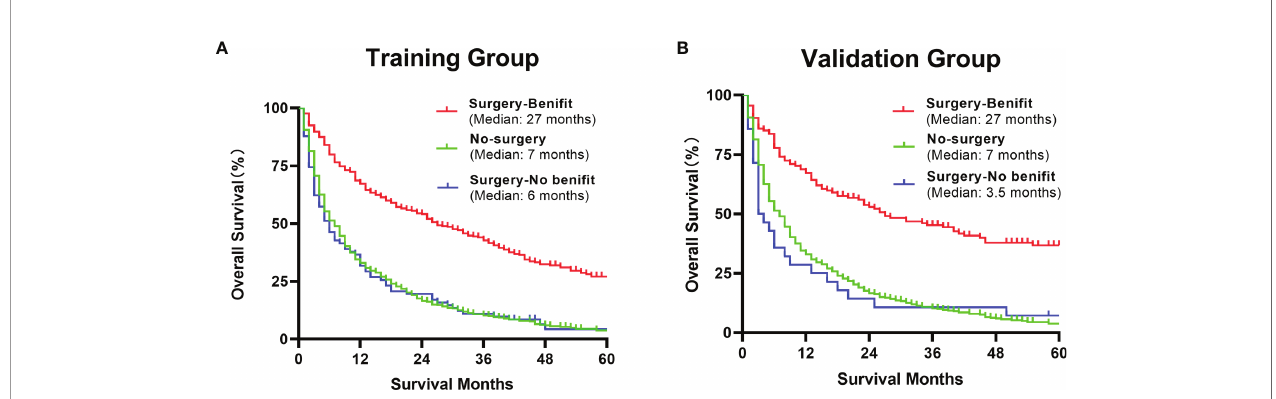
FIGURE 11 | Kaplan – Meier analysis of a comparison of bene fi t candidates, no-bene fi t candidates and no-surgery patients in the training group (A) and validation group (B) after using our